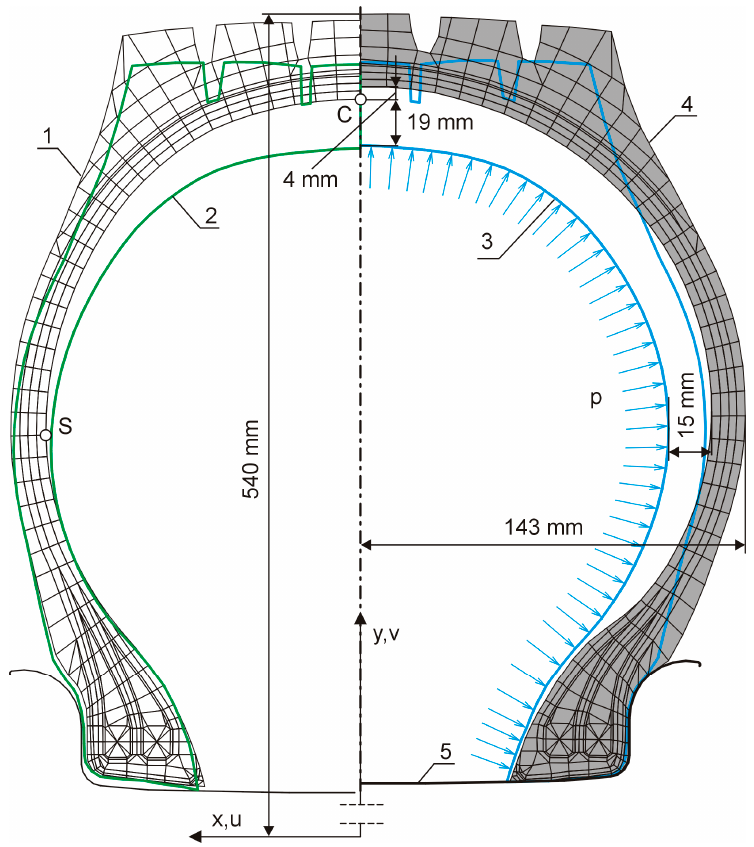
Figure 5. Bias truck tire; 1 – profile in mold and finite element mesh, 2 – outside the mold (shrunk), 3 – profile after mounting on rim, 4 –inflated up to p n ; 5 – rim.